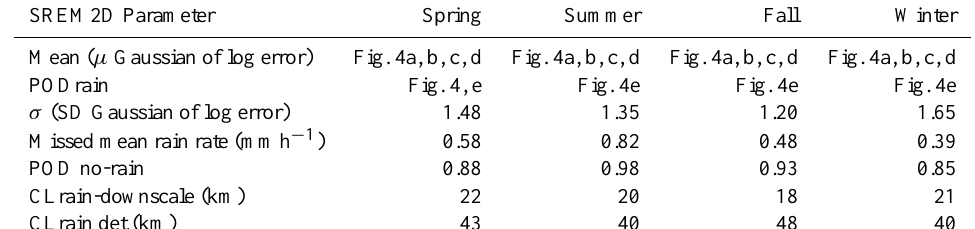
Table 3. SREM2D parameters determined for GLDAS downscaling for the four seasons using the calibration events.